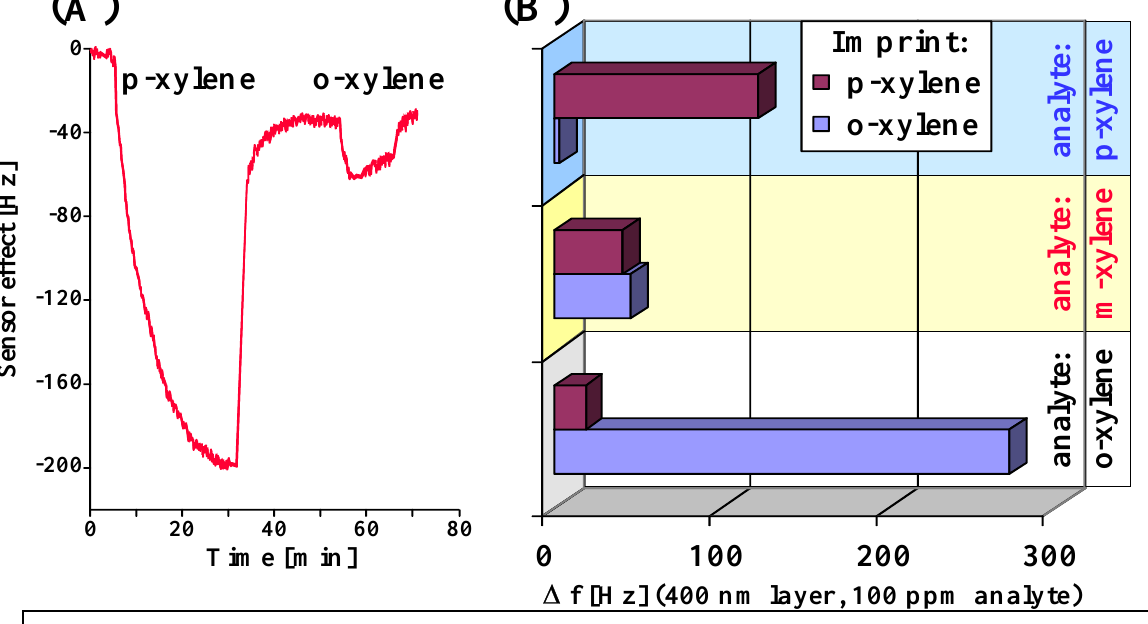
Fig. 4 (A) Fregquency response of a 10 MHz QCM coated with a p-xylene imprint. (B) Selectivity pattern of the oo- and